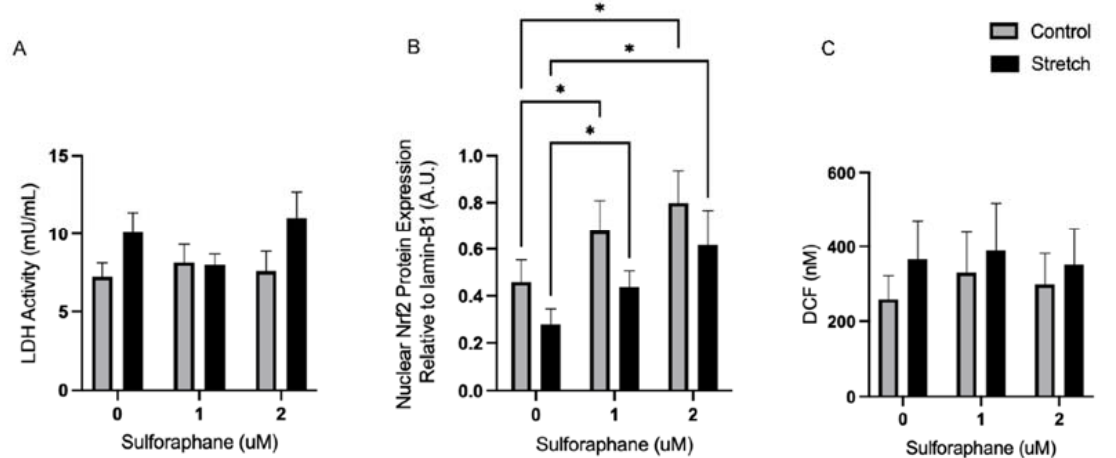
Figure 4. Sulforaphane rescued stretch-mediated Nrf2 downregulation independent of stretch. ( A ) Kinetically measured LDH activity (mU/µL) with sulforaphane treatment. ( B ) Nuclear Nrf2 protein expression relative to Lamin-B1 with sulforaphane treatment. ( C ) DCF production with sulforaphane treatment. Data displayed as mean ± STDEV. * p < 0.05 vs. control or untreated cells (two-way ANOVA).